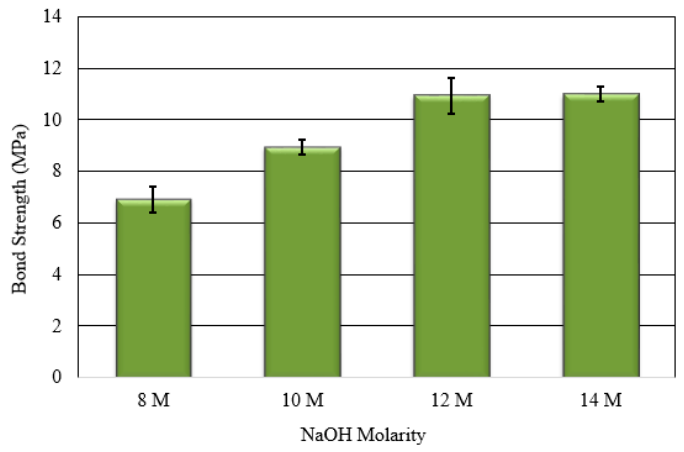
Figure 6. Bond strength of FA-based geopolymer paste with various NaOH molarity.